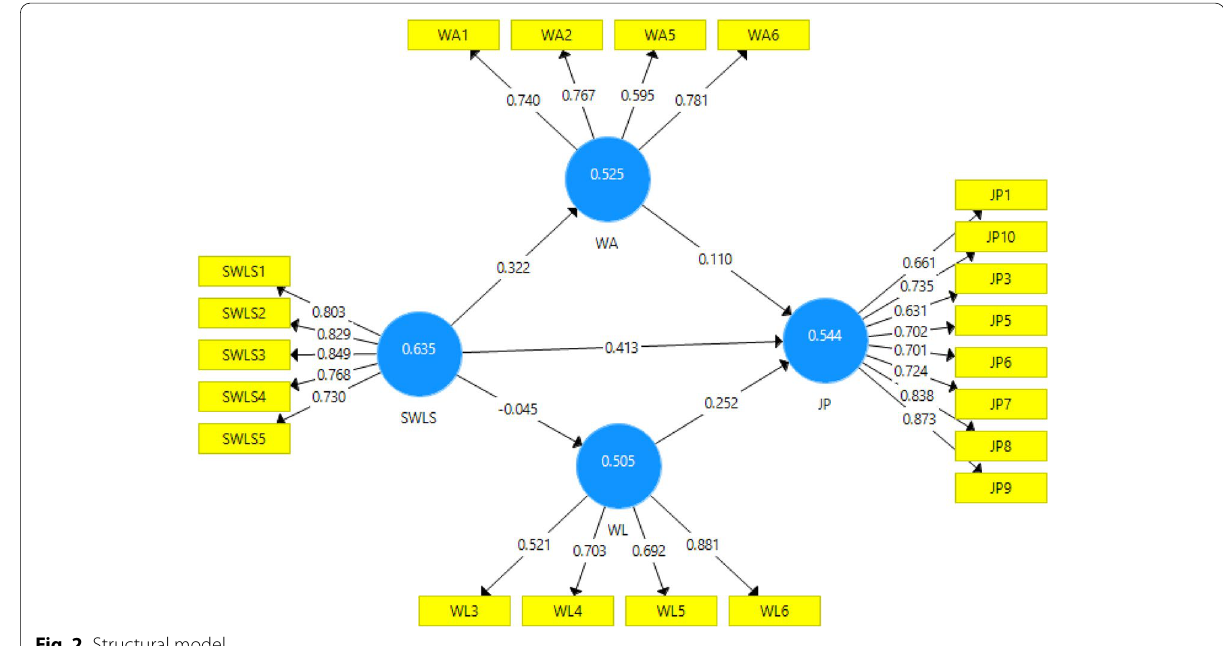
Fig. 2 Structural